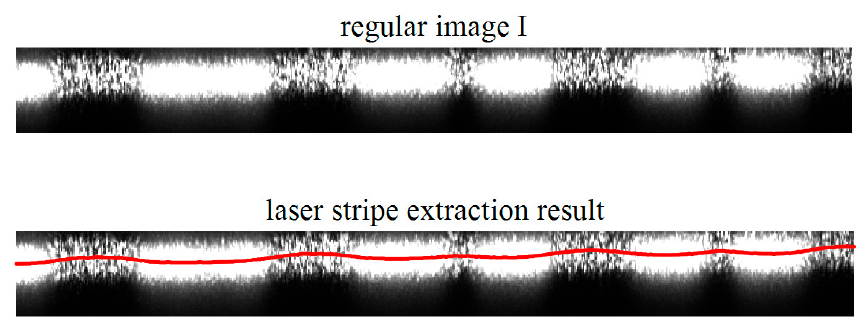
Figure 8. Regular image and laser stripe extraction result (red line). I m × n is the corresponding region of the laser bounding box in the regular grey image. Times ( a , b ) represent the element-by-element multiplication of two matrixes a and b , which are in the same size. Suppose that the direction of the laser line is along the columns of WL m × n as it is shown in Figure 8, the sub-pixel result of laser stripe extraction LoL m × 1 is located by Equation